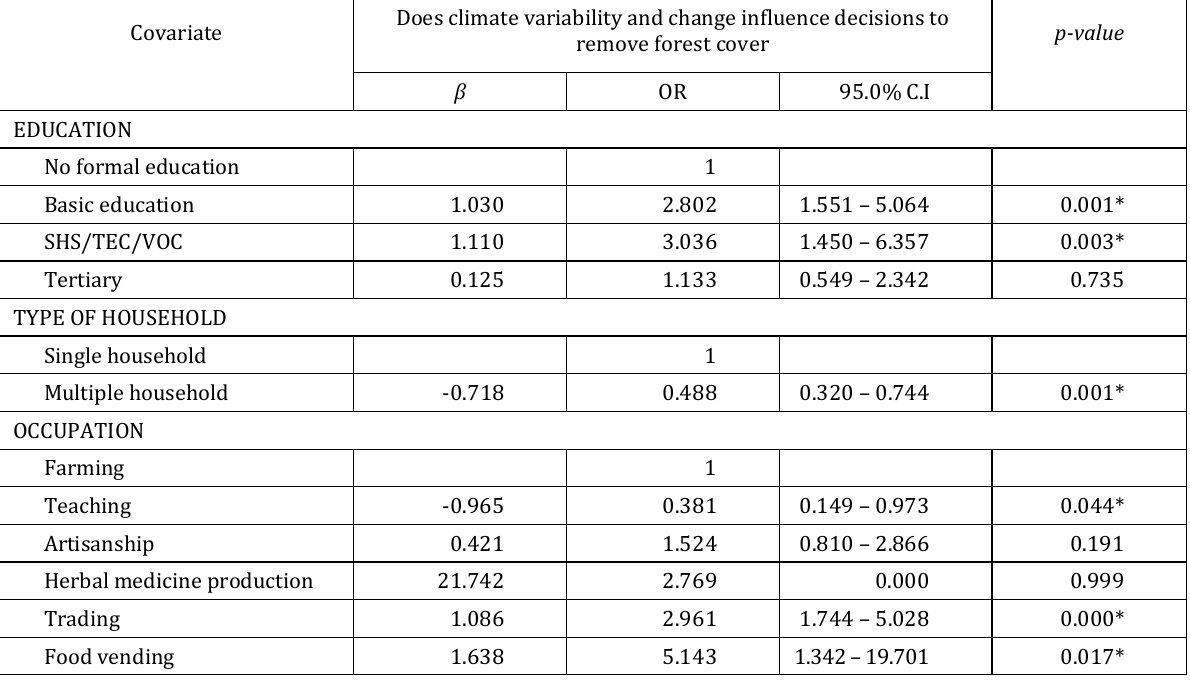
Table 4. Predictors of the impact of CVC on forest cover removal